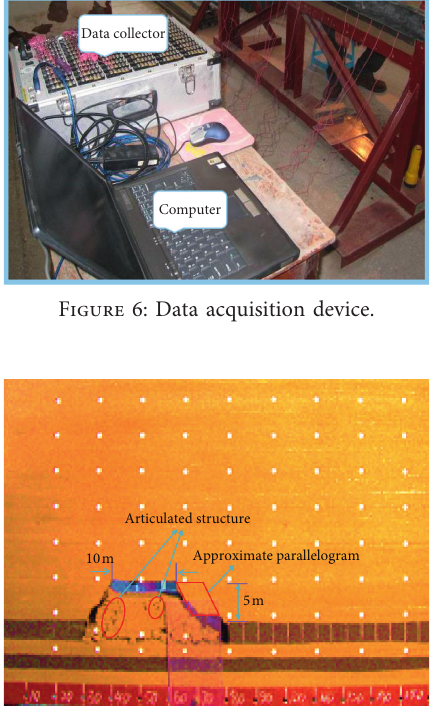
Figure 7: 25m advancement.